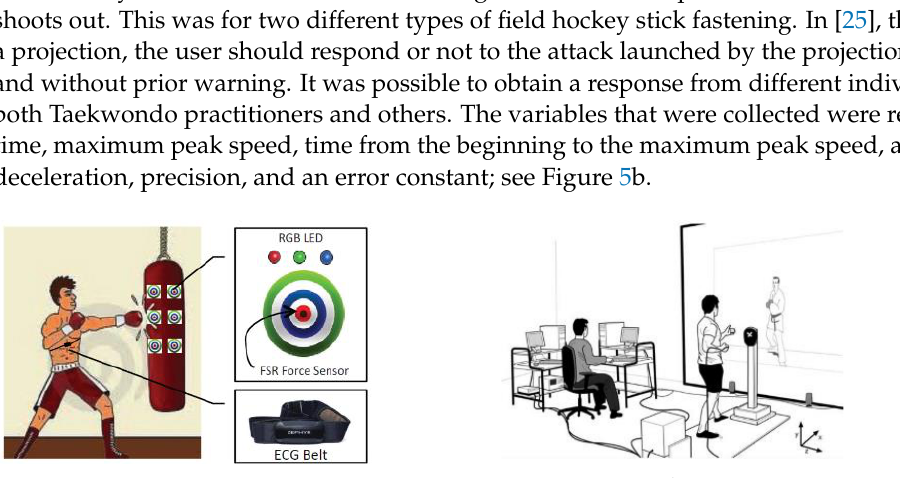
Figure 4. ( a ) Microstrain ® wireless inertial sensor; ( b ) Head Impact System with accelerometers.